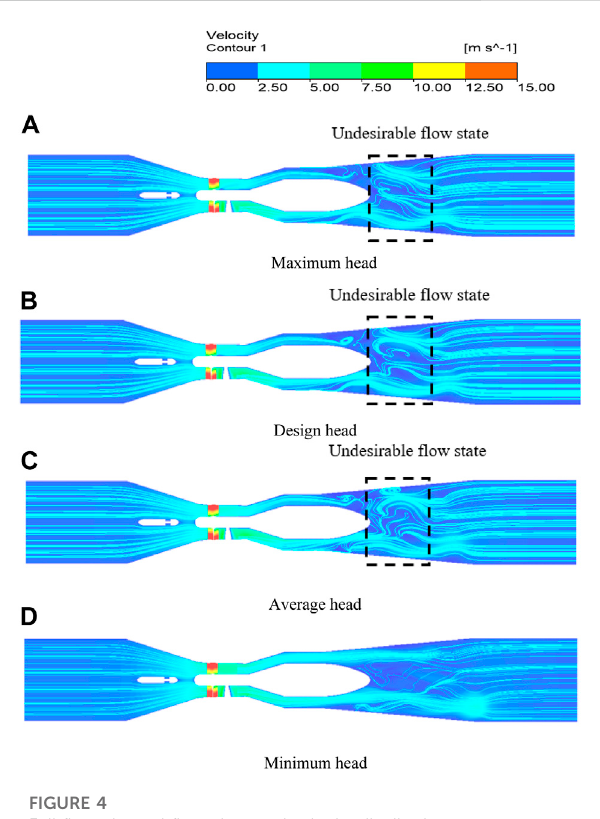
FIGURE 4 Full fl ow channel fl ow chart and velocity distribution contour chart. (A) Maximum head. (B) Design head. (C) Average head. (D) Minimum head.